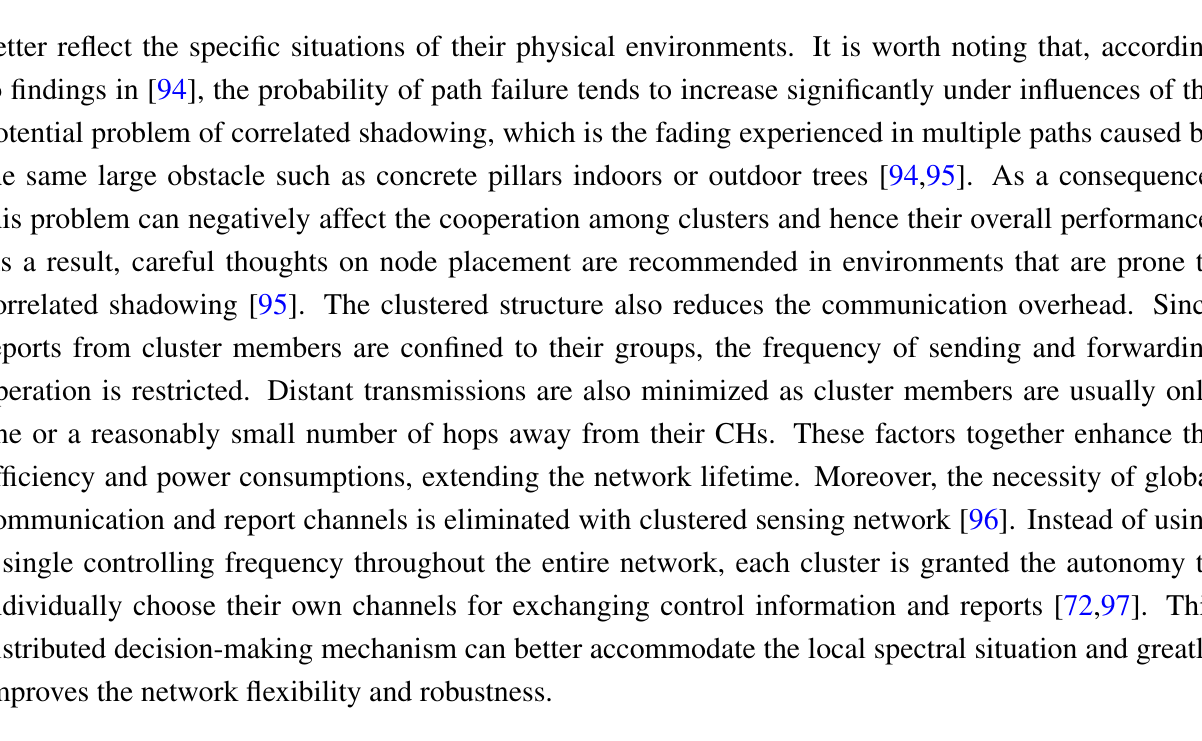
Table 3. Summary of cooperation models.